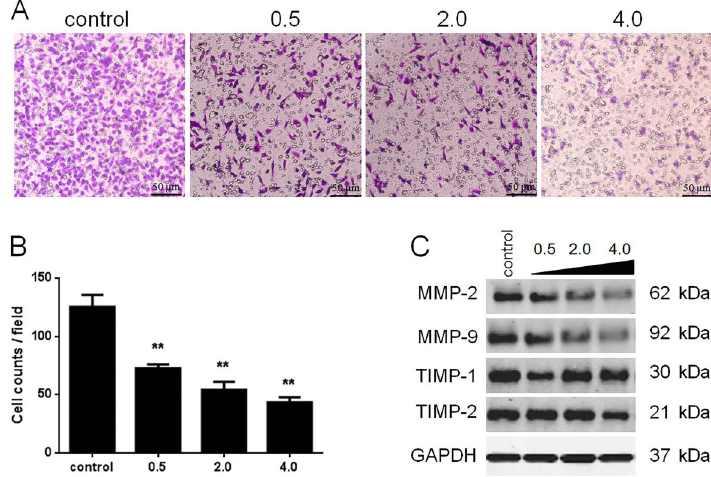
Figure 3. Inhibitive effects of ethanol extracts of Antrodia cinnamomea (EEA) on SAS cell invasion. A , SAS cells were plated into the upper chamber in medium supplemented with various concentrations of EEA. After 36-h incubation, invading cells were counted in fi ve randomly selected fi elds (scale bars: 50 m m. B , The average counts of invading cells were signi fi cantly less in groups treated with EEA than in control. C , Effects of EEA on invasion-associated proteins, including MMP-2, MMP-9, TIMP-1, and TIMP-2, were evaluated by western blot. Data are reported as means ± SD. **P o 0.01